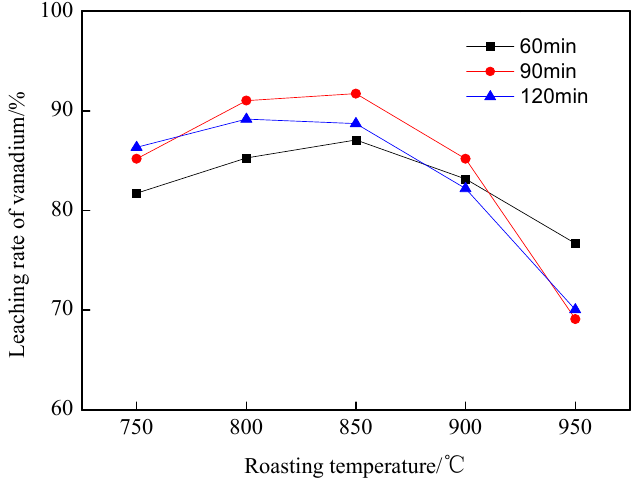
Figure 4. Effect of temperature and time on the leaching rate of vanadium.